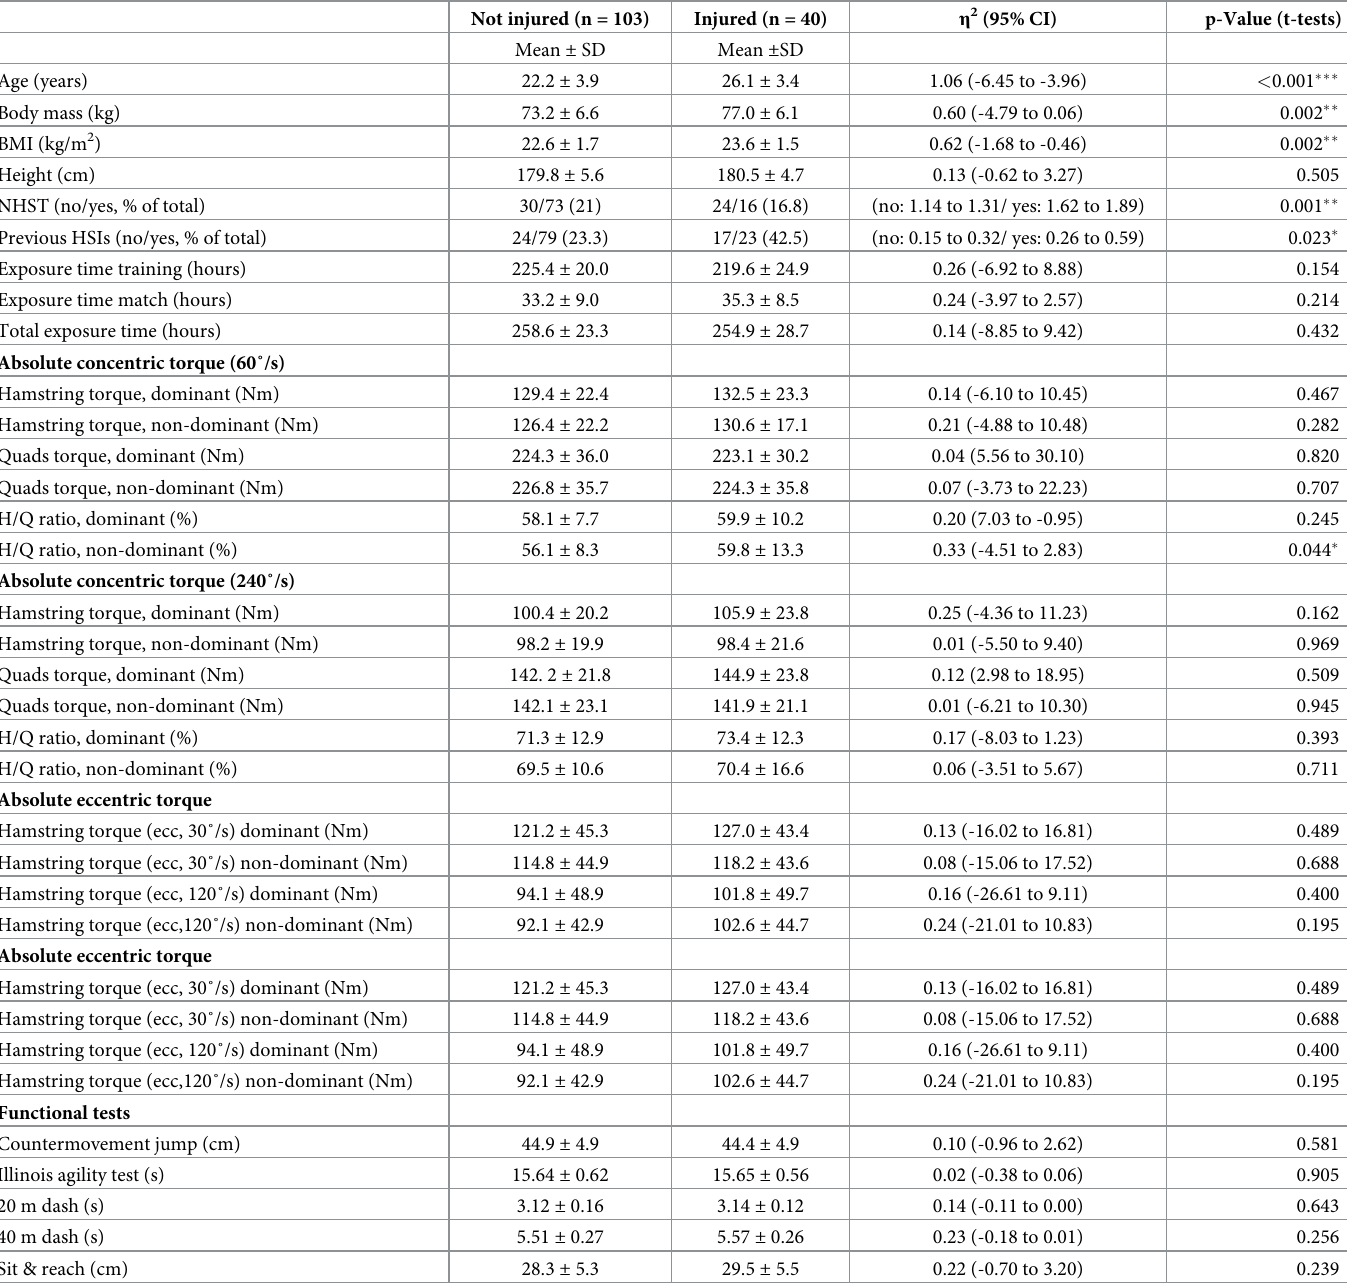
Table 3. Characteristics according to age, anthropometric and physical fitness parameters between HSIs injured and non-injured